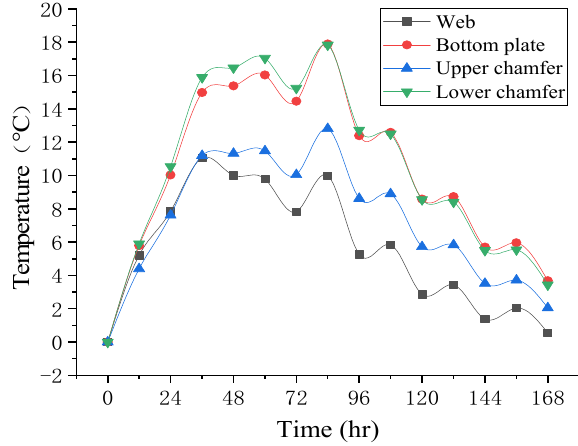
Figure 9. Time–history curves between the inside and outside of the box girder.